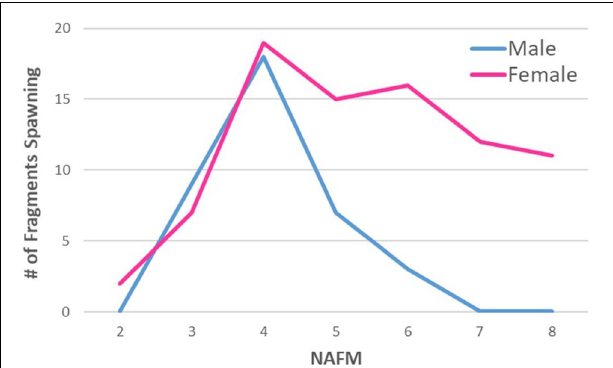
FIGURE 5 | Spawning time (minutes after sunset) of ex situ Dendrogyra cylindrus fragments compared to number of days held ex situ (logarithmic scale). Female spawn times are pink circles; male spawn times are blue triangles. Pink and blue horizontal lines indicate the average spawn time of in situ colonies from 2012 to 2018. The yellow vertical bar on the left indicates one lunar month (29.5 days); the yellow vertical bar on the right indicates one lunar year (354